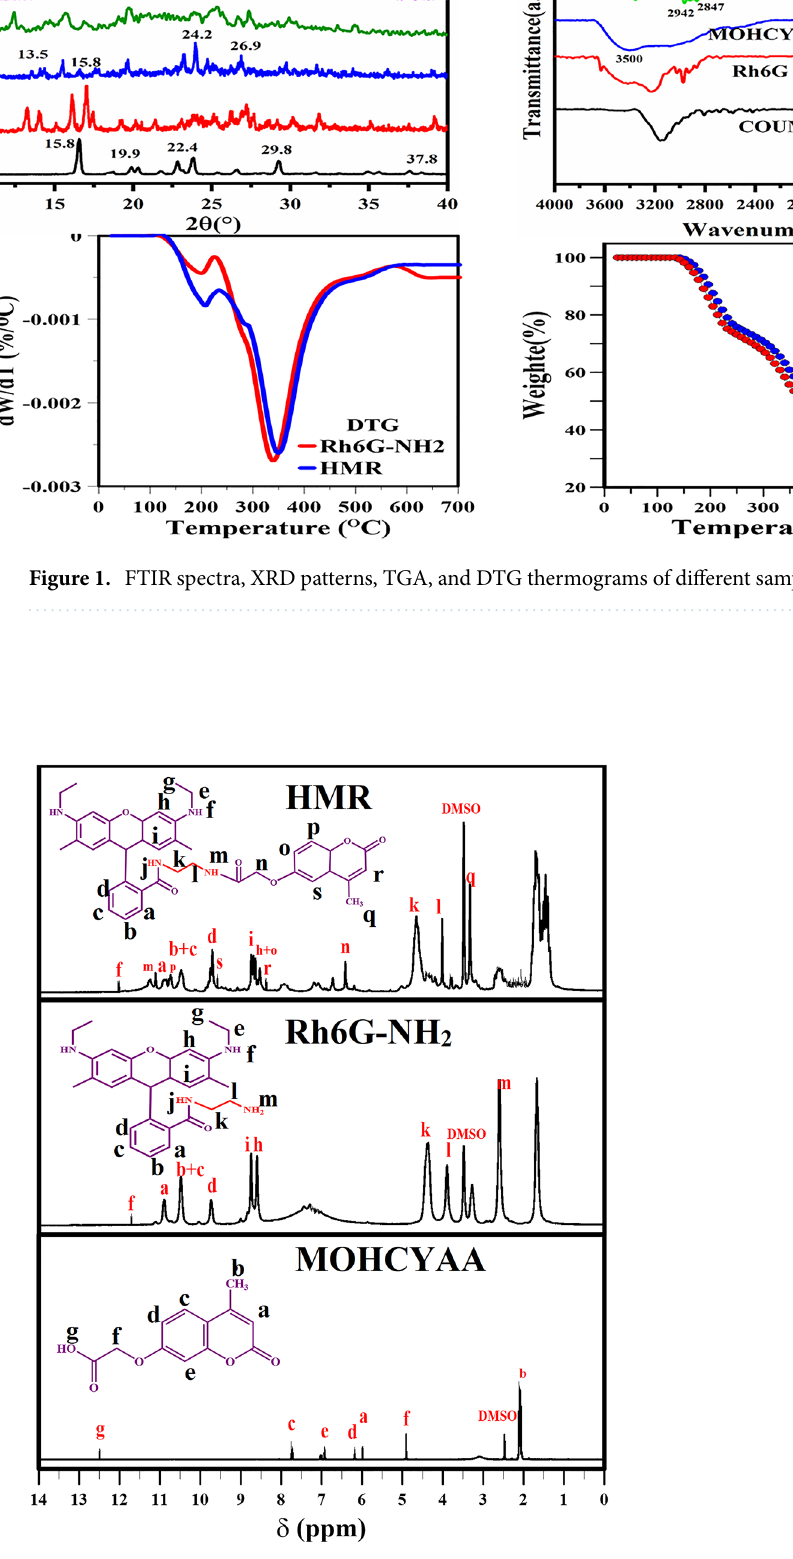
Figure 2. 1 H NMR spectra of MOHCYAA, Rh6G-NH 2 , and